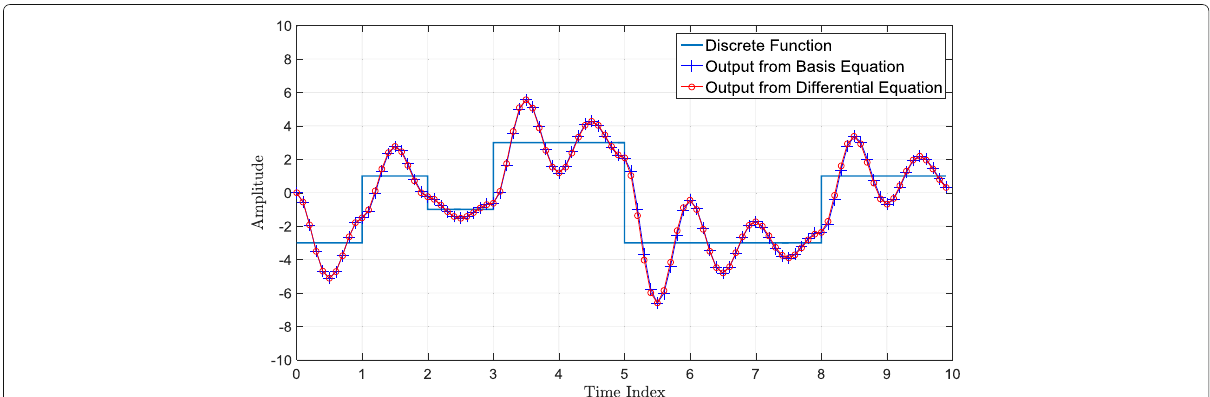
second and β = ln 2. Equation 10 emphasizes that the behavior of chaotic signals in the reverse time can be expressed in terms of an exact analytic